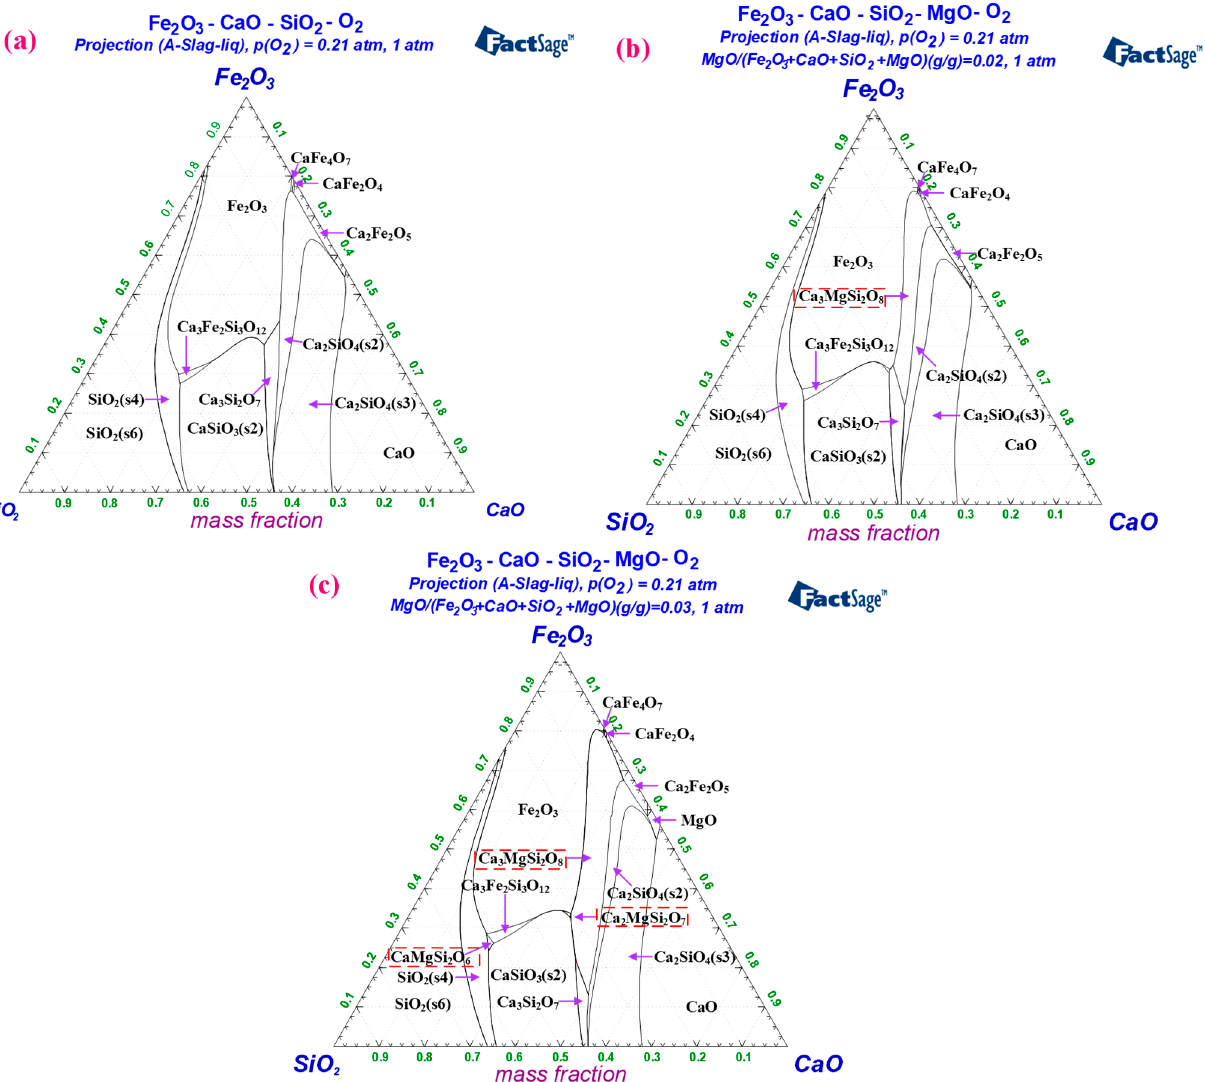
Figure 3. Phase diagram of ( a ) Fe 2 O 3 –CaO–SiO 2 , ( b ) Fe 2 O 3 –CaO–SiO 2 –2 wt%MgO, and ( c ) Fe 2 O 3 –CaO–SiO 2 –3 wt%MgO.